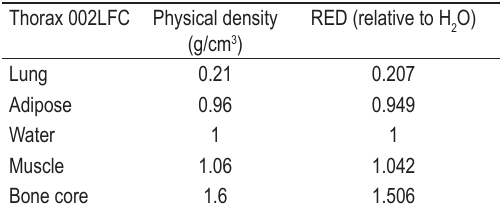
TABLE 2. Thorax 002LFC phantom relative electron and mass density